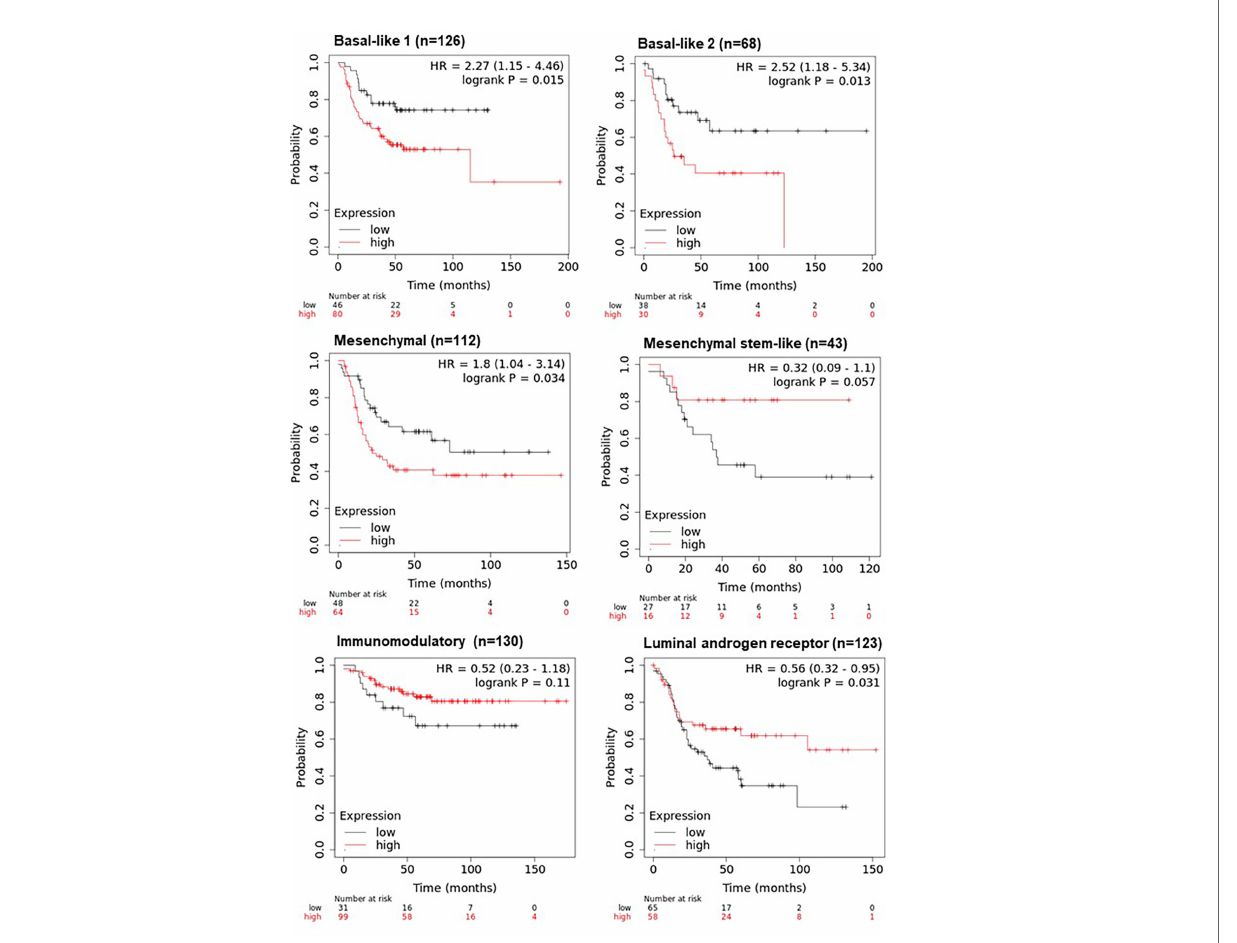
FIGURE 5 | KM plotter survival analysis of TNBC subtypes using the four-gene panel including ANP32E , DSC2 , IL6ST , and ANKRD30A . Survival analysis was performed in KM plotter using publicly available microarray data that is available within the database according to the TNBC subtypes of basal-like 1, basal-like 2, mesenchymal, mesenchymal stem-like, immunomodulatory and the luminal androgen receptor subtype. Cases were divided into high or low expression groups based on the median expression of the four-gene panel (with inverted expression of the two low expressed genes: ANKRD30A and IL6ST and not inverted for the two highly expressed genes: ANP32E and DSC2) and compared by Kaplan-Meier survival analysis. A Log-rank p-value ≤ 0.05 was considered signi fi cant. HR, hazard ratio. The red curve represents high expression, and the black curve represents low